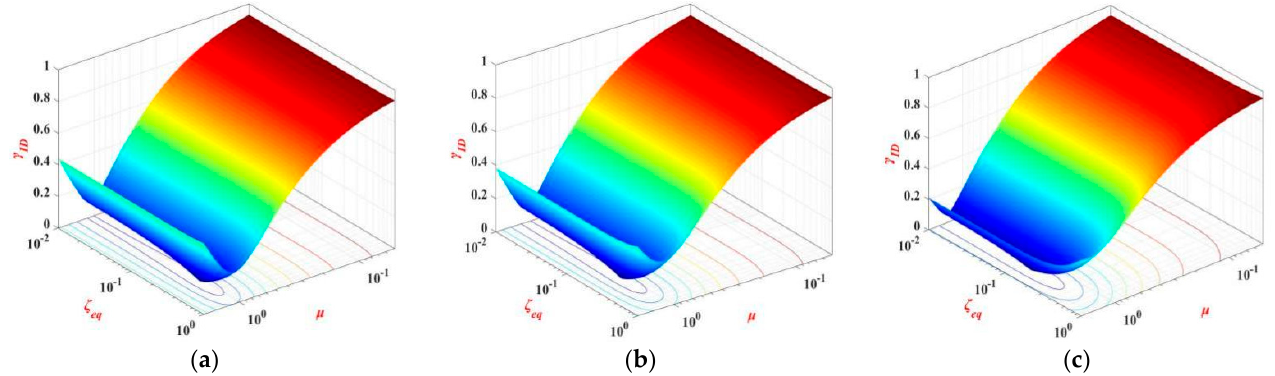
Figure 6. Contour plot of γ U of HB–1 : ( a ) κ = 0.05; ( b ) κ = 0.1; ( c ) κ = 0.3.